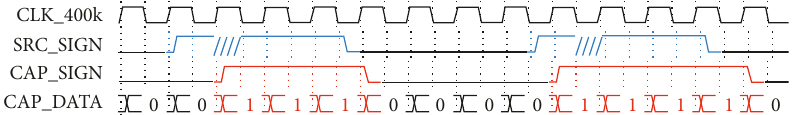
Figure 11: IR signal sampling at 400kHz sampling